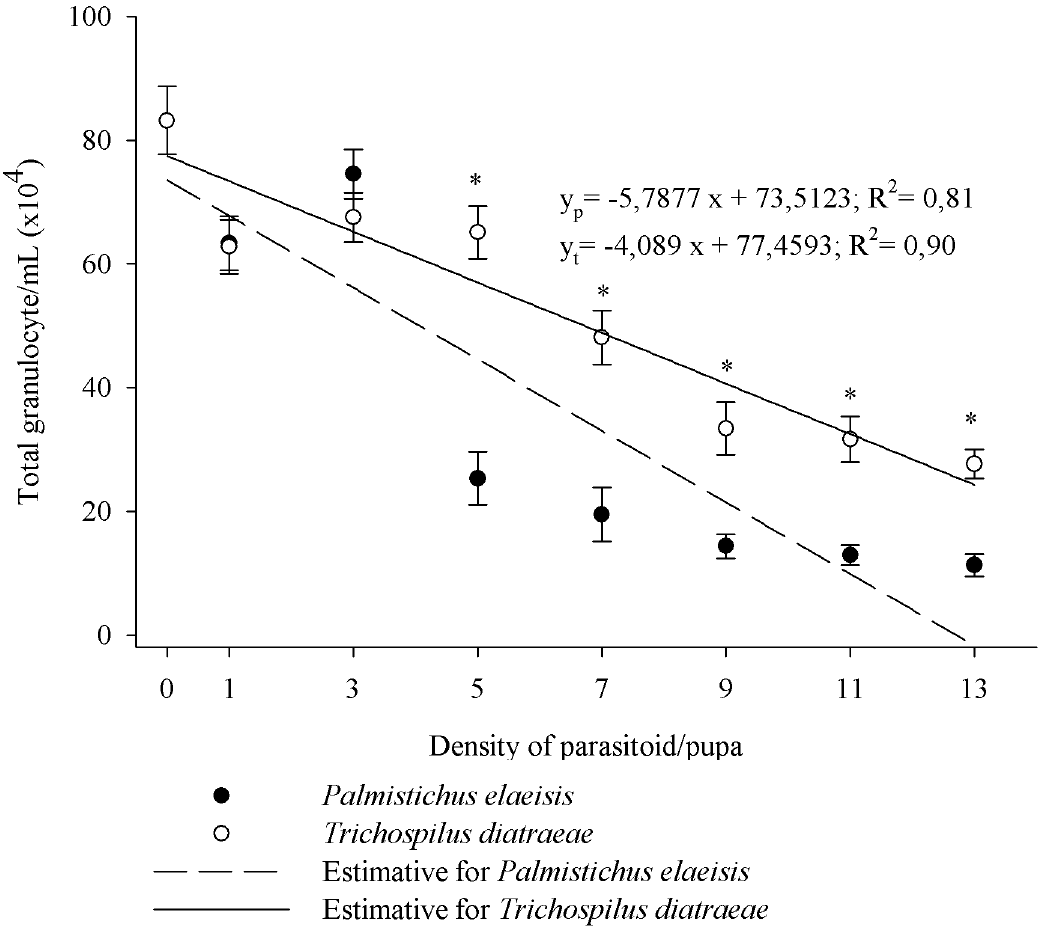
Figure 2. Total granulocyte (mean ± se) of Anticarsiagemmatalis pupae parasitized by densities of Palmistichuselaeisis or Trichospilus diatraeae .